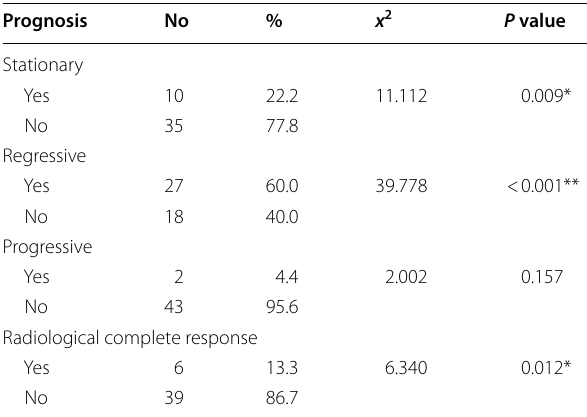
Table 3 Assessment of treatment response distribution among study group